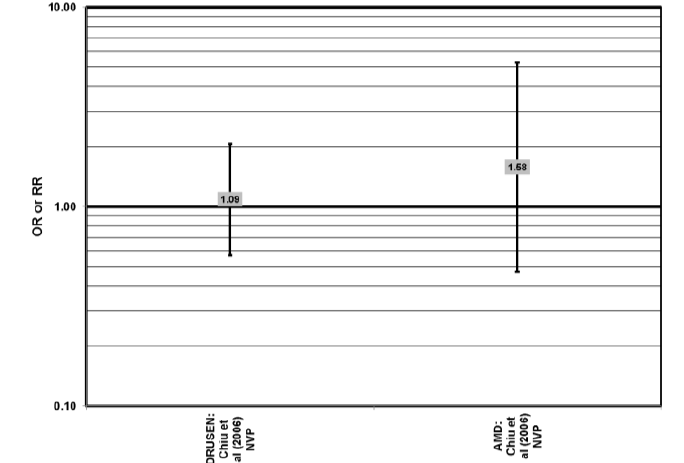
Figure 4. Odds or risk ratio for early AMD indicators (DRUSEN) or AMD; high vs. low intake of total carbohydrates: cross-sectional